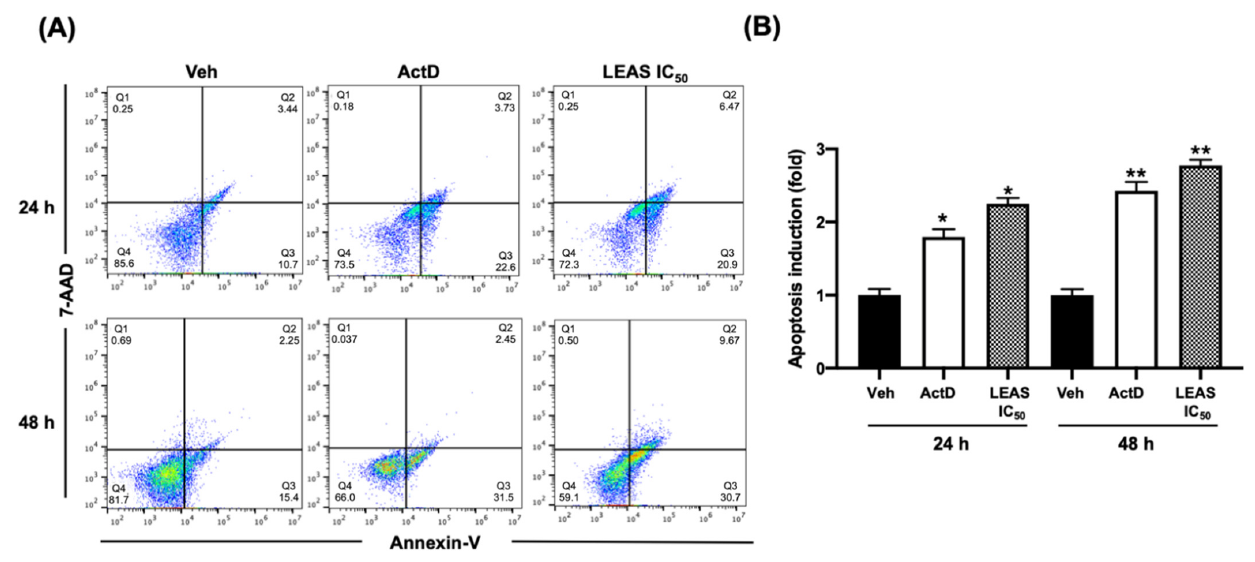
Figure 3 . Apoptosis induced by LEAS in D-17 cells. ( A ) Cells treated with LEAS IC 50 (15.5 µg/mL) for 24 h and 48 h were analyzed by flow cytometry using Annexin-V and /AAD staining to establish the apoptotic rate. Cells sorted into quadrants Q1, Q2, Q3 and, Q4 represent necrotic, late apoptotic, early apoptotic, and viable (live) populations, respectively. Representative plots are shown. ( B ) The graphic shows the apoptosis fold-change in the treatments at times evaluated. Each bar shows the mean of triplicates ± SE. A minimum of 10,000 events per sample was collected. * and ** indicate statistically significant differences with respect to vehicles ( p < 0.05) at the different times evaluated. ActD = Actinomycin D (80 µg/mL). Veh = vehicle (DMSO 0.1%).